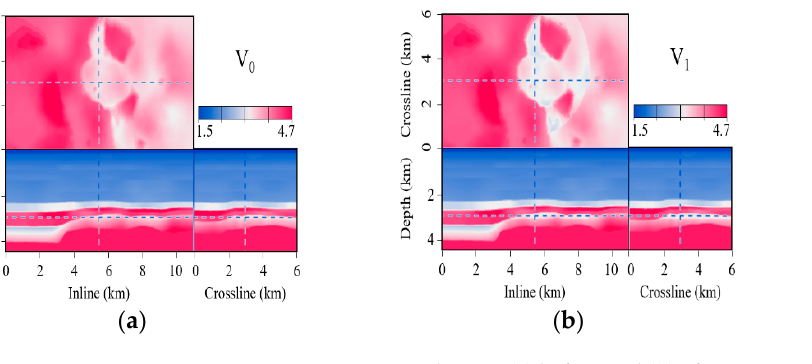
Figure 4. P wave velocities ( a ) before and ( b ) after CO 2 injection in the Volve oil field. It was assumed that CO ₂ was injected at depth of 3 km, and this can be confirmed in ( c ) the subtraction between the two velocity models. The yellow star and black dotted line in Figure 5 indicate the source and receiver location, respectively.